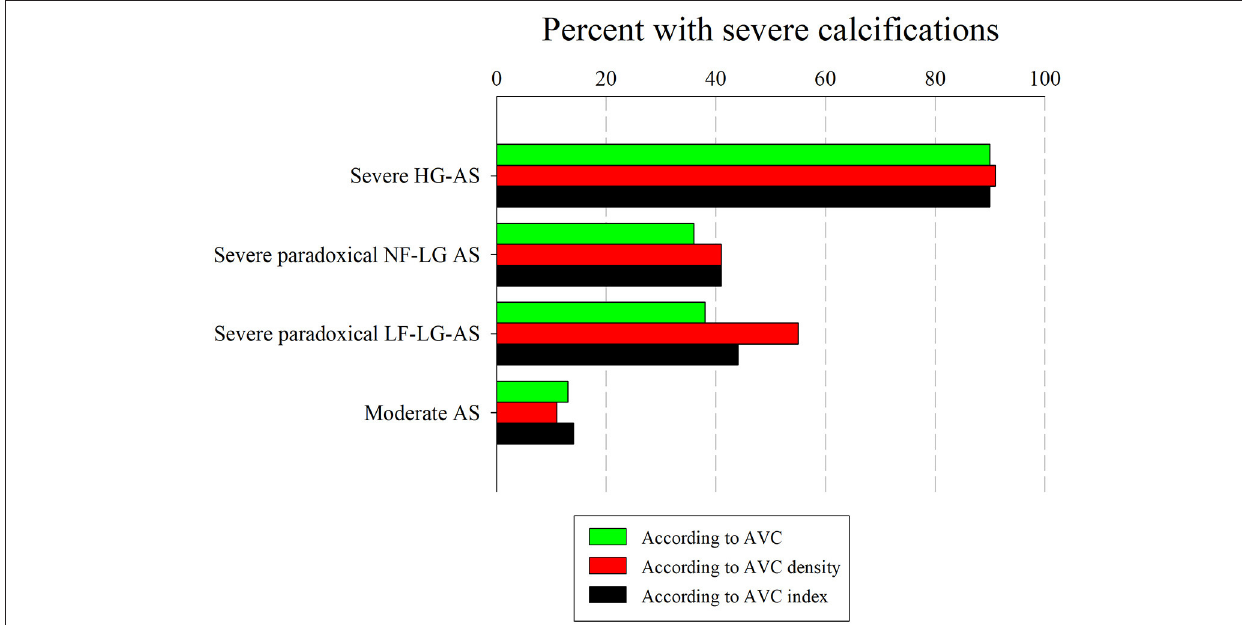
FIGURE 6 | Percent of patients with high AVC load in the different AS severity groups. Percent patients with high Agatston score (in green), high AVC density (in red) and high AVC index (in black) in subgroups with severe HG-AS, severe paradoxical normal flow (NF) or low flow (LF) LG-AS and moderate AS.